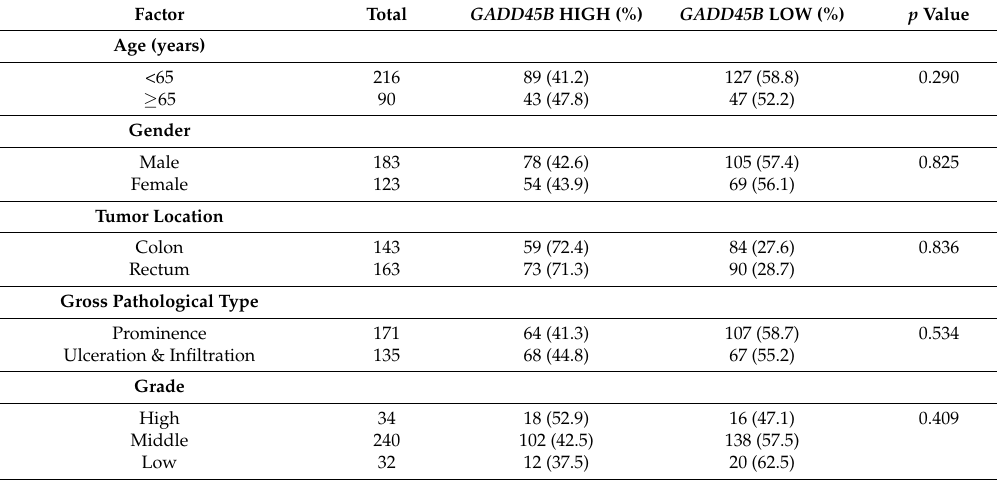
Table 2. Correlation between the intensity of GADD45B expression and the clinical profiles of stage II colorectal